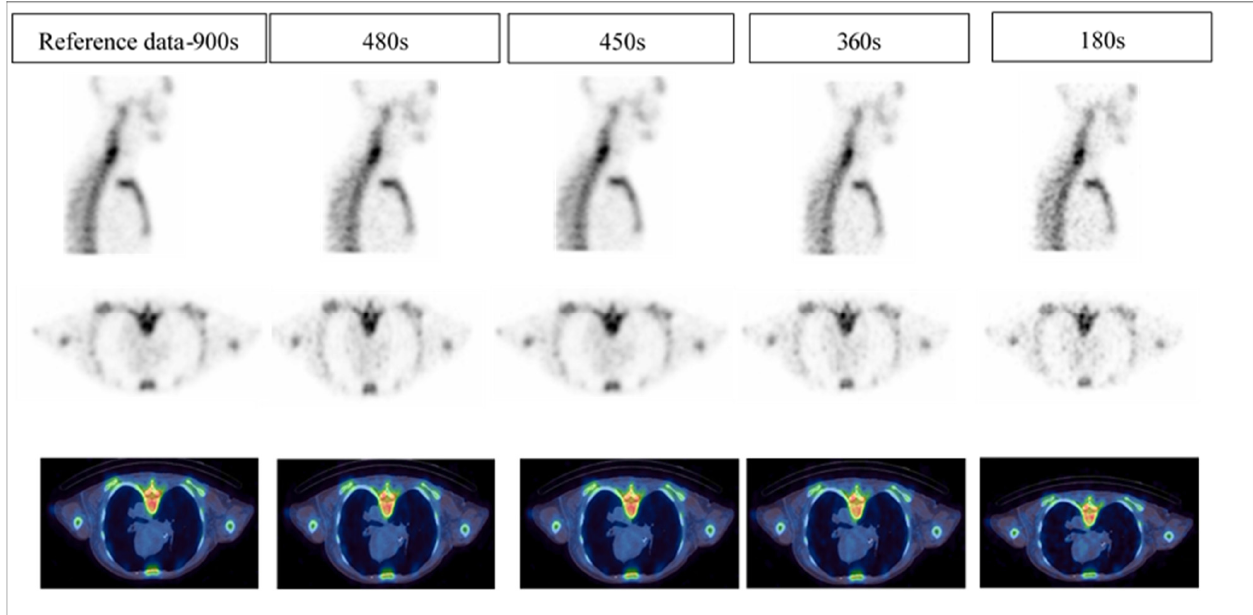
Figure 2. An example of subjective image quality. The image quality scores of 4, 3, 3, 2 and 1 were given to the reference images-900 s, 480 s, 450 s, 360 s and 180 s, respectively.